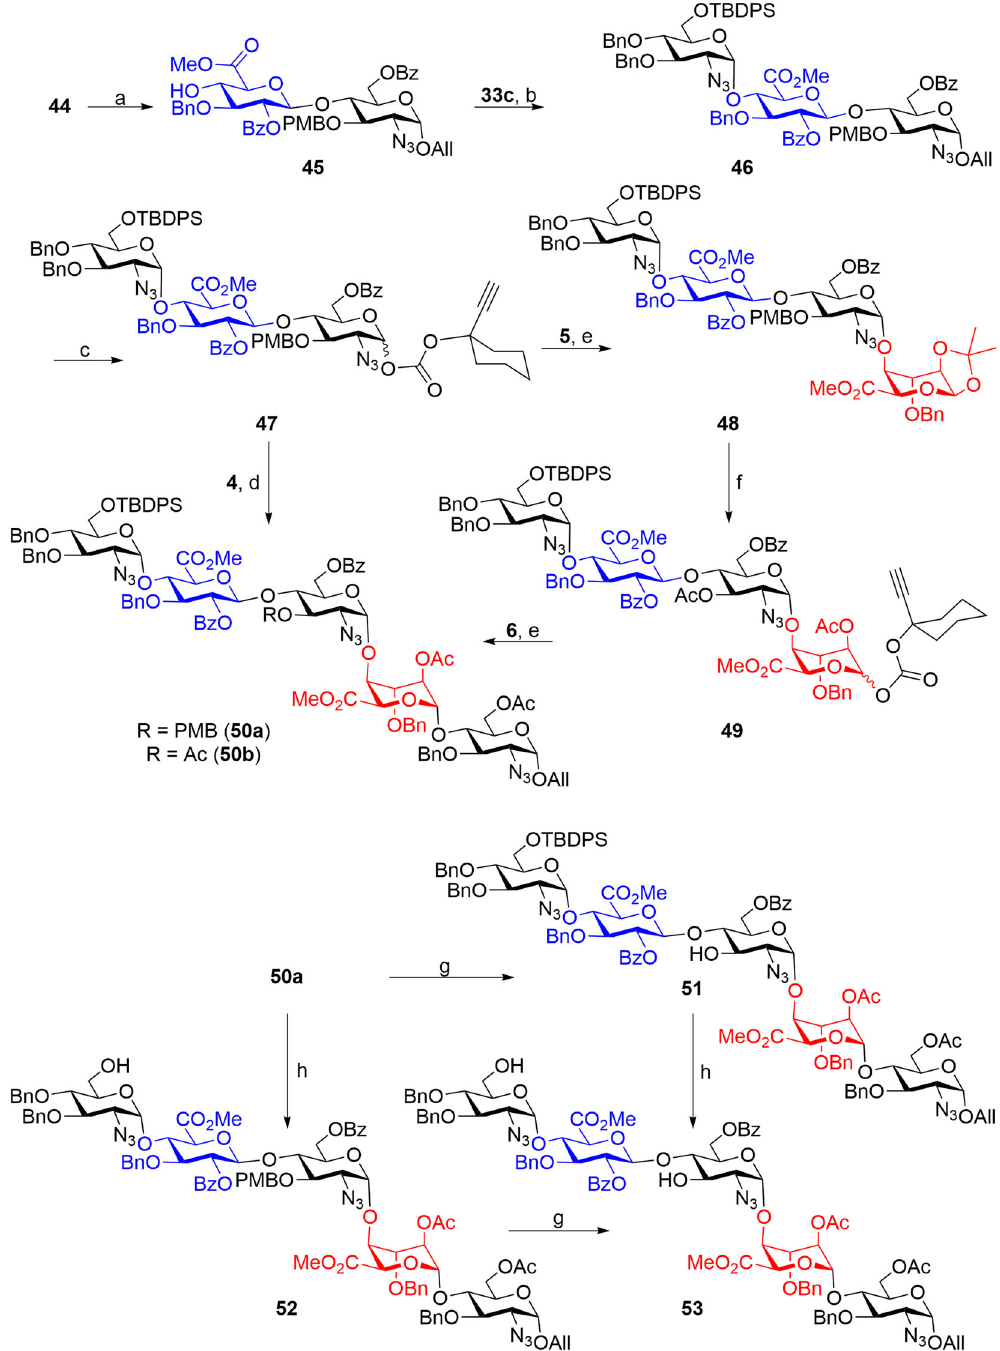
Fig. 6 Synthesis of fondaparinux pentasaccharide reagents. a HF (cid:129) py, pyridine, 0 – 25 °C, 5 h, 89%; b 15 mol% each of 25 and AgOTf, CH 2 Cl 2 , 4 Å MS, − 40 °C, 1 h, 90% ( α only); c (i) PdCl – CH 2 , MeOH 2 Cl 2 (3:1), 25 °C, 4 h, 87%; (ii) 24 , DMAP, CH 2 Cl 2 , 25 °C, 3 h, 88%; d 10 mol% each of 25 and AgOTf, CH 2 Cl 2 , 4 Å MS, − 10 °C to 25 °C, 30 min, 86% ( α only); e 8 mol% each of 25 and AgOTf, CH 2 Cl 2 , 4 Å MS, 25 °C, 15 min; 48 : 91% ( α only), 50b : 75%; f (i) 75% Dichloroacetic acid (aq), 0 °C, 1 h, 68%, (ii) 24 , DMAP, CH 2 Cl 2 , 25 °C, 3 h, then Ac 2 O, 25 °C, 2 h, 71% over two steps. g DDQ, CH 2 Cl 2 : H 2 O (10:1), 25 °C, 30 min, 51 : 85%, 53 : 76%; ( h ) HF (cid:129) py, pyridine, 0 – 25 °C, 5 h, 52 : 83%, 53 : atmosphere and the mixture was stirred at 70 °C for 1h. This method was utilized saturated aqueous ammonium chloride solution, water (20 mL) and extracted with for the preparation of compounds 15 , 16 , and 19 . EtOAc (3× 10 mL). The combined organic phases were washed with brine solution (10 mL), dried over anhydrous Na 2 SO 4 , and concentrated in vacuo. The crude residue was puri fi ed by silica gel column chromatography using EtOAc and hexane Preparation of glycosyl carbonate donors from allyl glycosides . Hemiacetals from allyl (30 – 35%) as a mobile phase to afford aryl carbinols as Ido- or Glc- isomers. glycosides . To a biphasic solution of the allyl glycoside (1.0mmol) in 3:1 CH 3 OH: Grignard reagent preparation: To a freshly activated Mg-metal (1.5 mmol) and 10 CH 2 Cl 2 (20 mL) was added 0.15 equivalent of PdCl 2 and the reaction mixture was mL of the anhydrous THF in two necks round bottom fl ask equipped with a stirred for 4-8h at 25°C, the reaction was quenched by adding an excess of Et 3 N condenser was added aryl/heteroaryl bromide (1.0mmol) slowly under argon and fi ltered through a bed of Celite ® . The fi ltrate was concentrated in vacuo and the